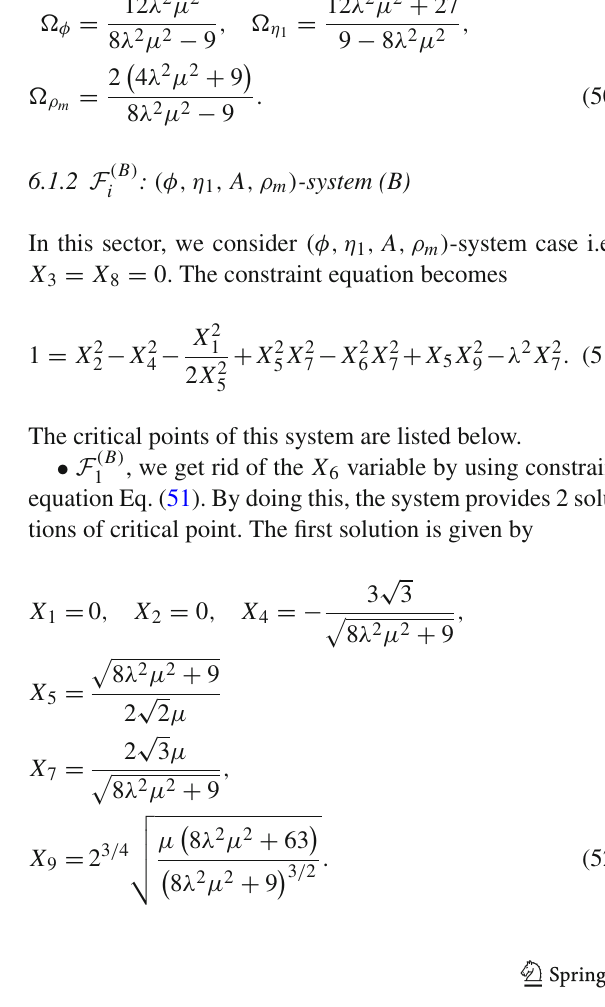
Fig. 1 On the left panel, the graph a shows the stability of the F ( A ) critical point. The stable critical points lie in the blue shaded region while non-shaded region is forbidden for critical points. On the right